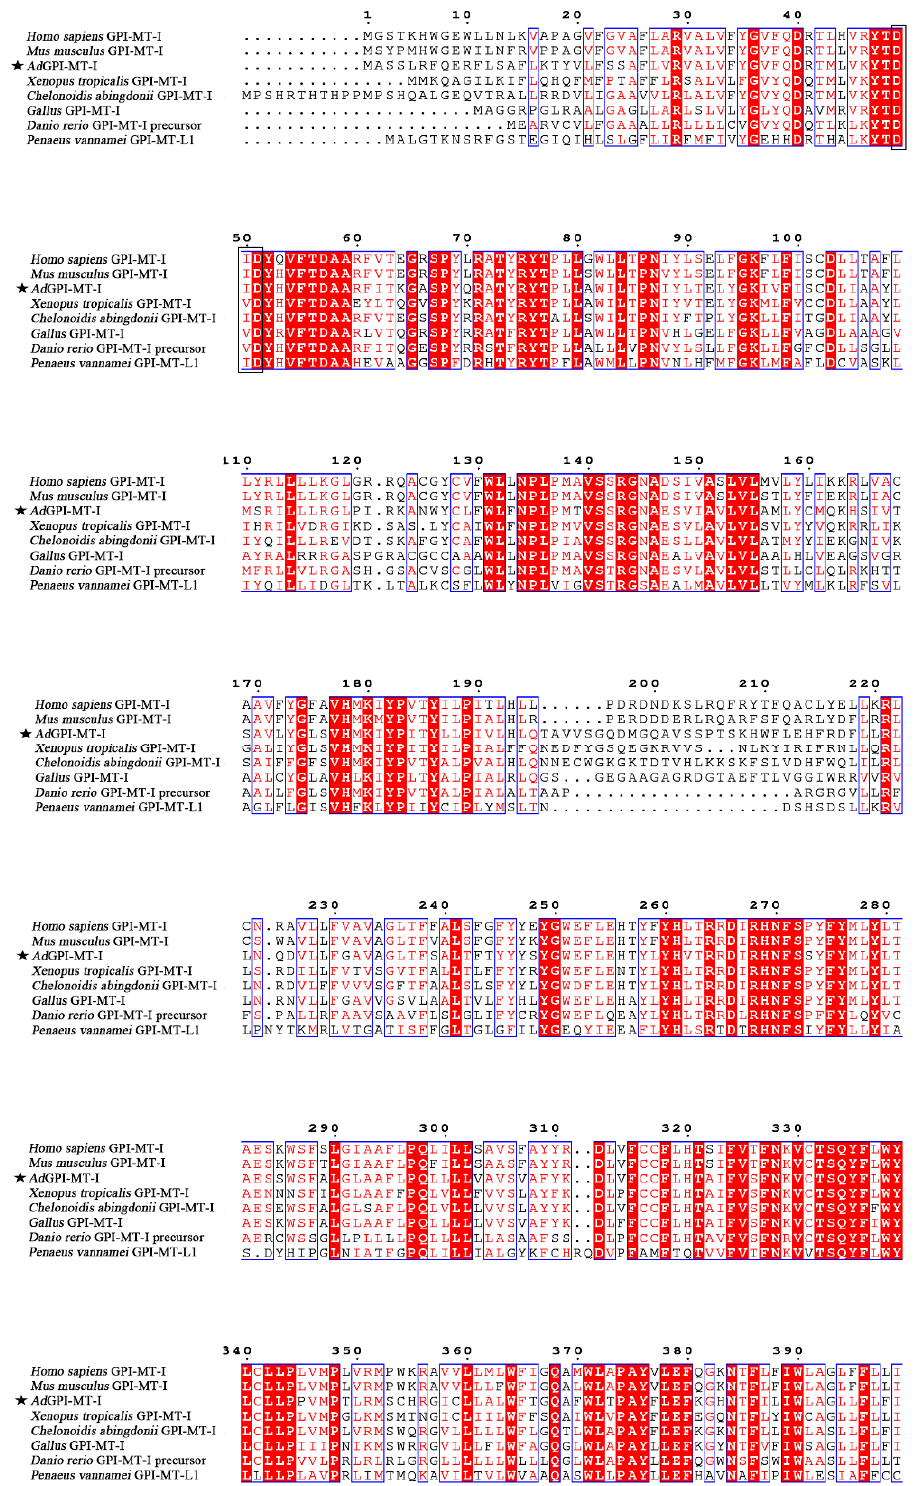
Figure 2. Multiple sequence alignment by Clustal W of GPI-MT-I gene encoding proteins from different species. Consensus residues are shaded in red; residues that are ≥ 75% identical among the aligned sequences are identified with red letters. The AdGPI-MT-I is marked with a pentagram ( ★ ), and the DXD motif is marked with a black box ( □ ). The sequences used are listed in Table 1.